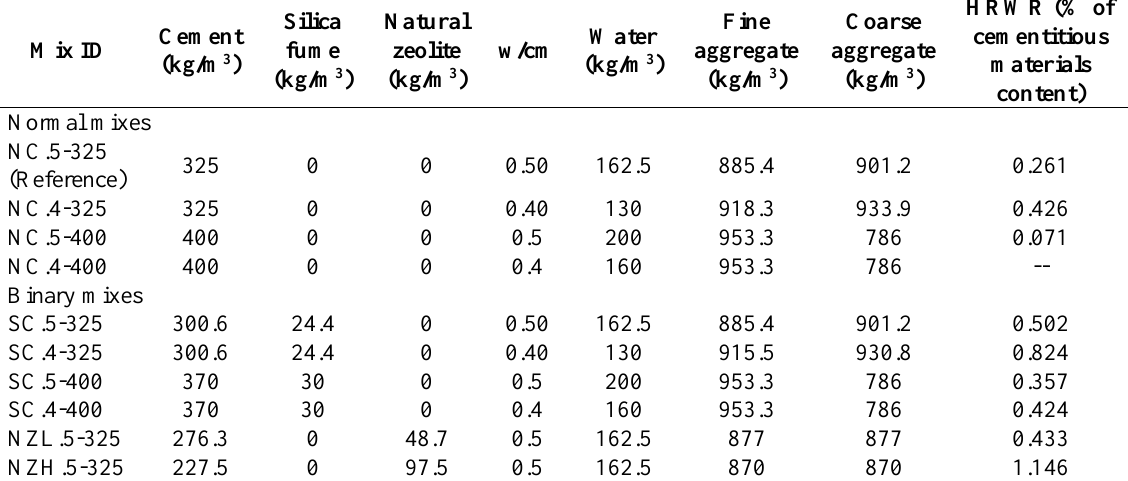
Table 5. Mixture proportions of the selected